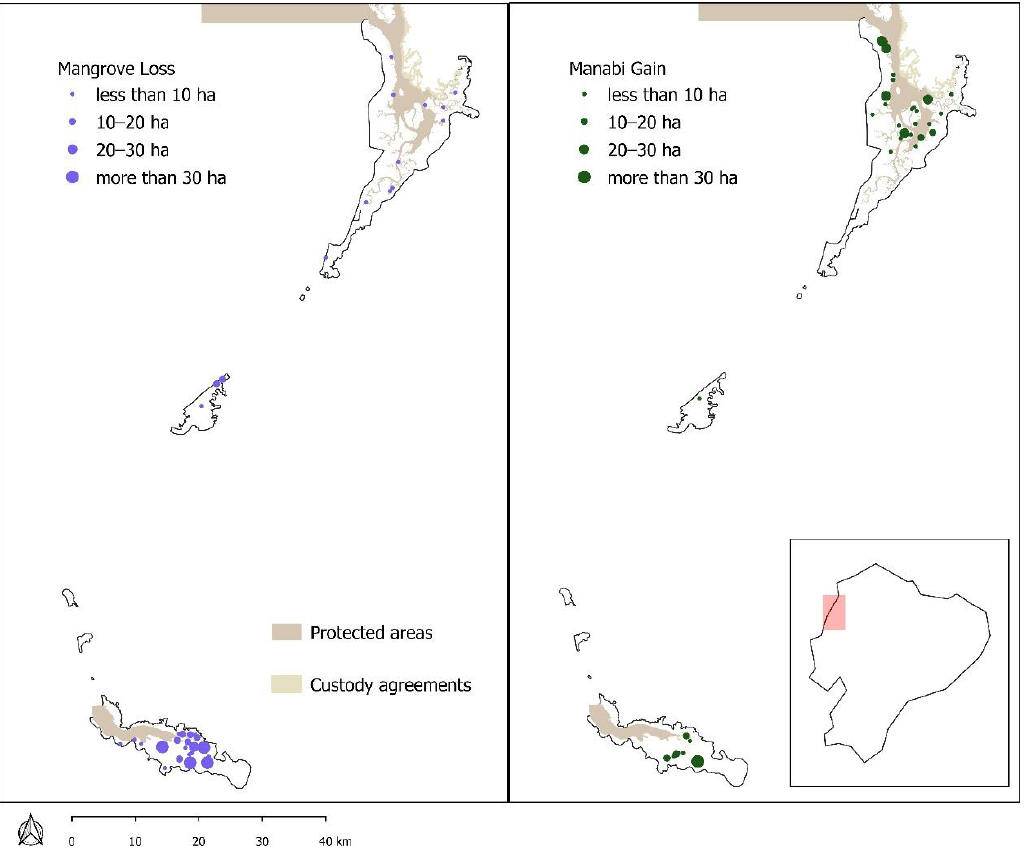
Figure 8. Mangrove losses and gains in the Manabí province between 1998 and 2016.